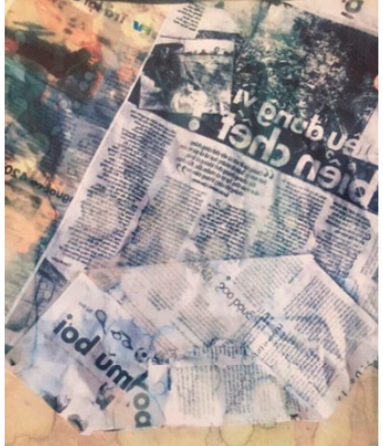
Figure A30. The picture Dieu dung vi bien chet (Distress because of the dead sea)—the group of journalists PVT—Thanh Quang. Where the Bien chet plagiarized from. The image was sourced from VnExpress (Thanh 2017).